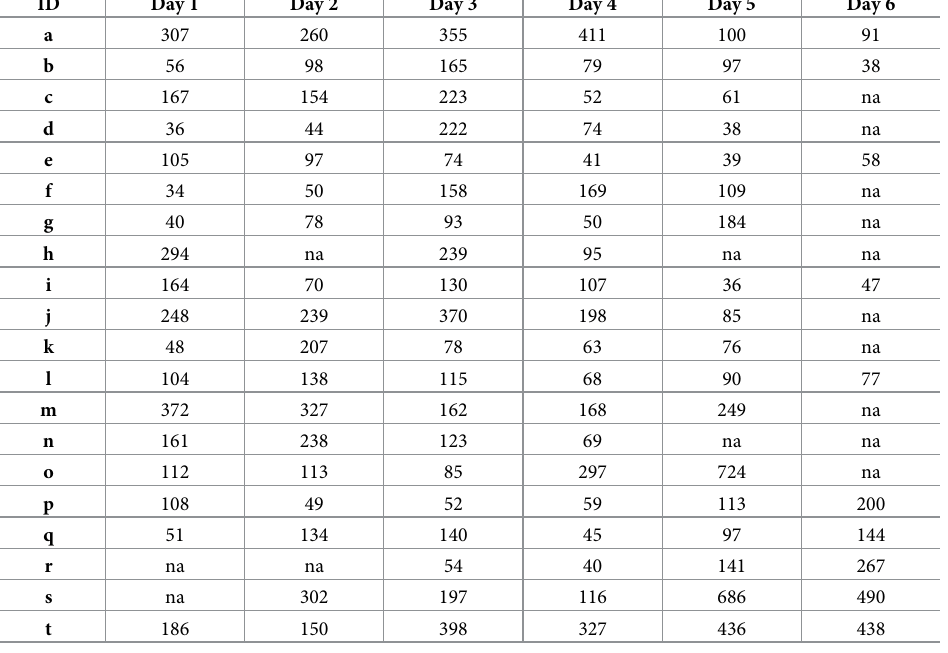
Table 1. Densitometric values of C3/C3a dot blot analysis of 20 AKI patients at the ICU. Urine samples were obtained at consecutive time points over 6 days.